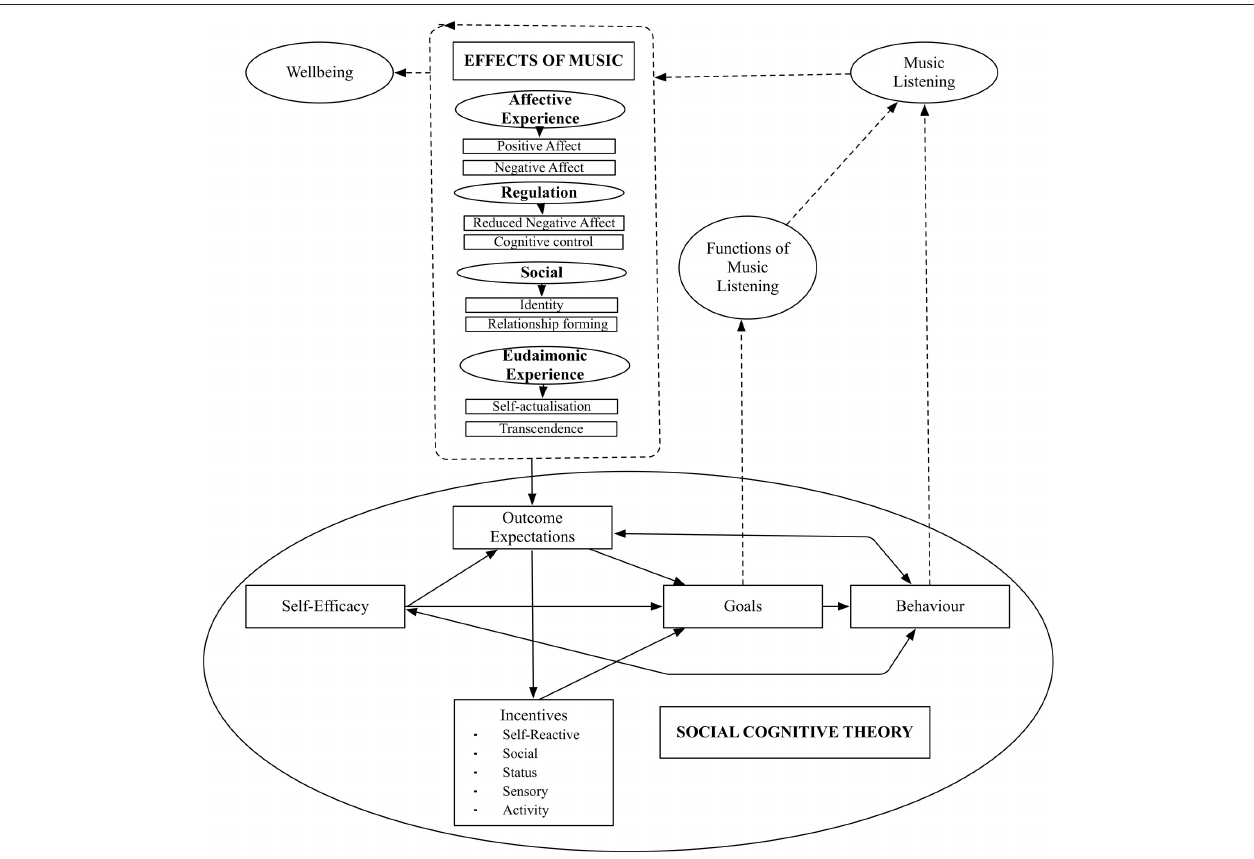
FIGURE 1 | Adaptive effects of music listening identified in the literature linked with functions of music listening via Social Cognitive Theory (Bandura, 1989,